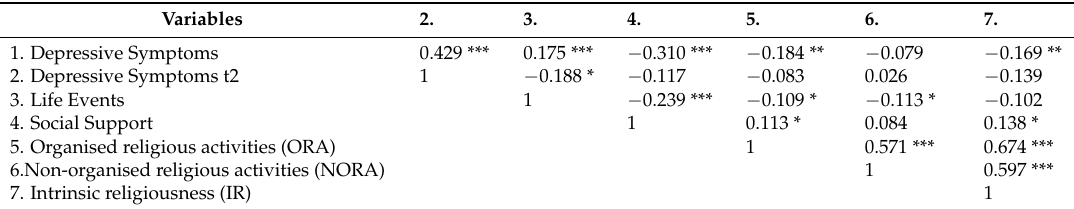
Table A1. Partial correlations between study variables (controlled for sex and